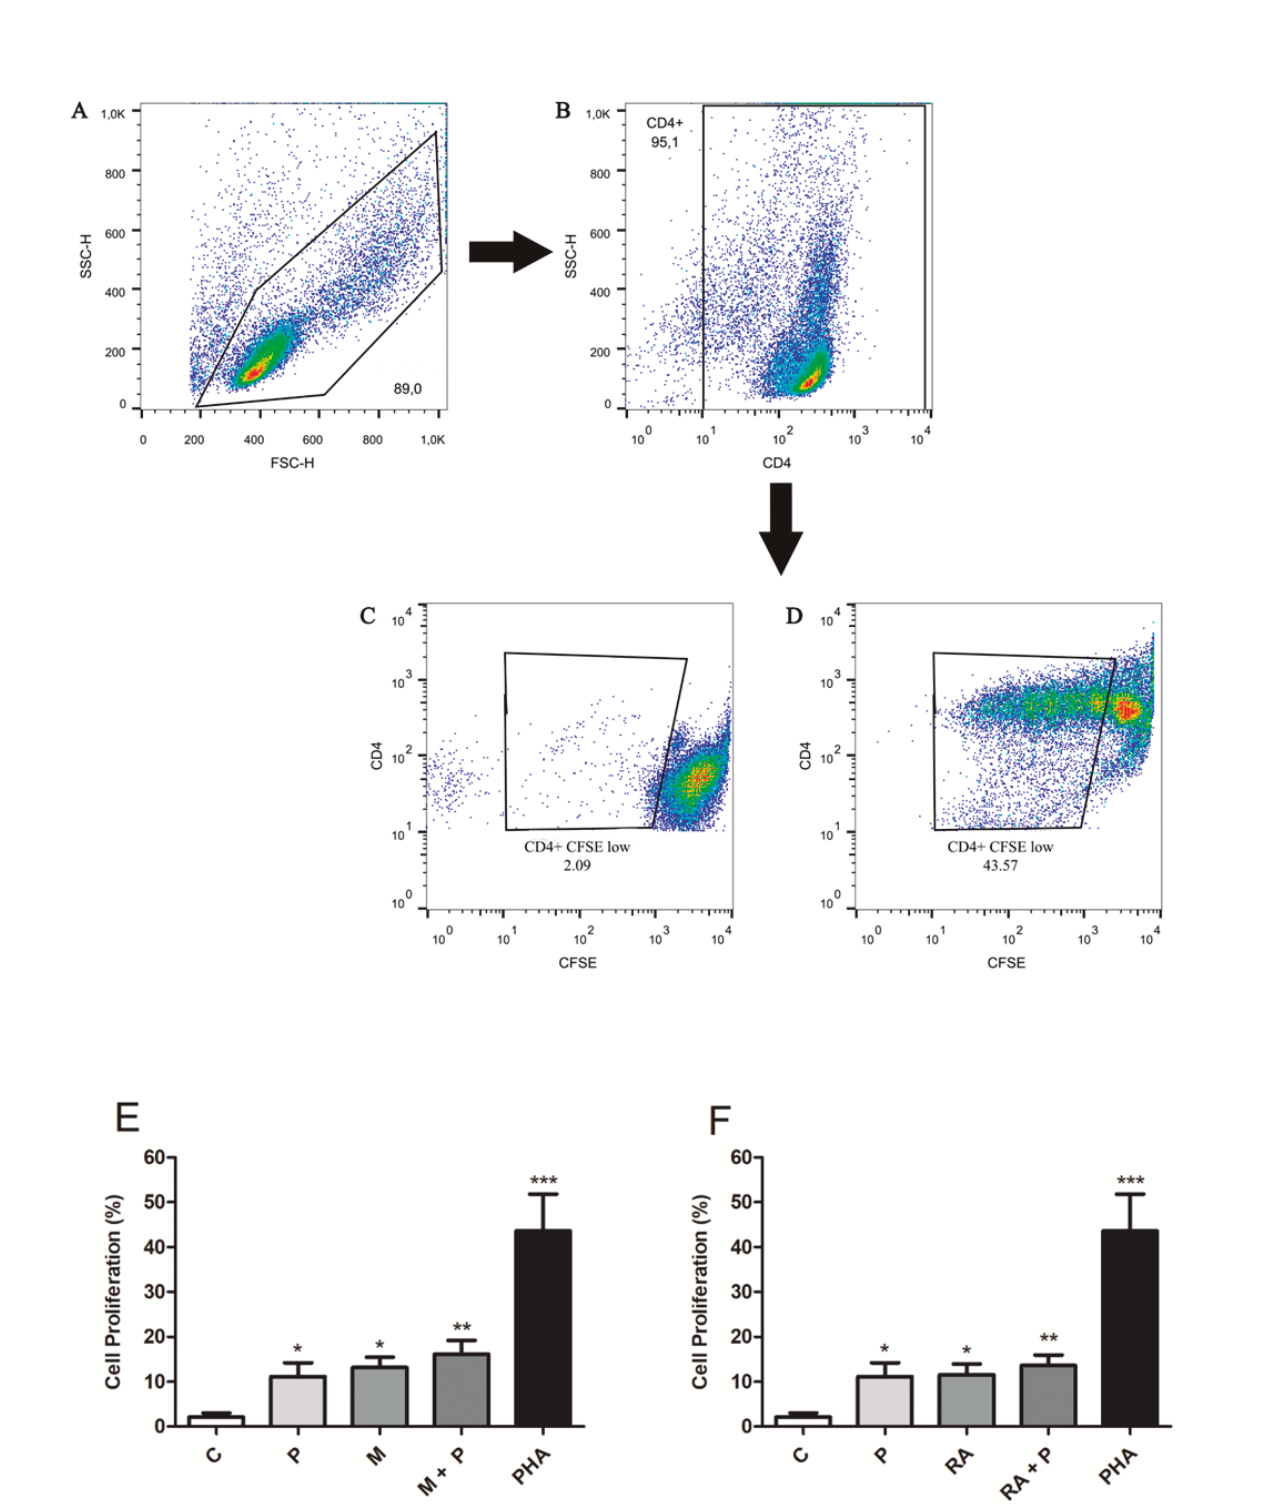
Figure 4. Representative dot plots of lymphocyte proliferation after 120 h of co-culture with autologous dendritic cells. (A) Gate of lymphocytes by size (FSC-H) x granularity (SSC-H). (B) Gate of CD4 + cells. (C) Proliferation of control lymphocytes (cells incubated with RPMI). (D) Proliferation of lymphocytes incubated with the positive control (PHA – 2.5 μg/mL). Percentage (%) of lymphocytes (1 × 10 6 cells/mL) proliferation after 120 h of co-culture with autologous dendritic cells treated only with RPMI 1640 (control – C), PHA (2.5 μg/mL), propolis (P – 5 μg/mL), (E) MAGE-1 (M – 10 μg/mL), (F) retinoic acid (RA – 10 -7 M) and their combination for 48 h. Data represent mean and standard-deviation (n = 5). Significantly different from control: *( p < 0.05); **( p < 0.01); ***( p <